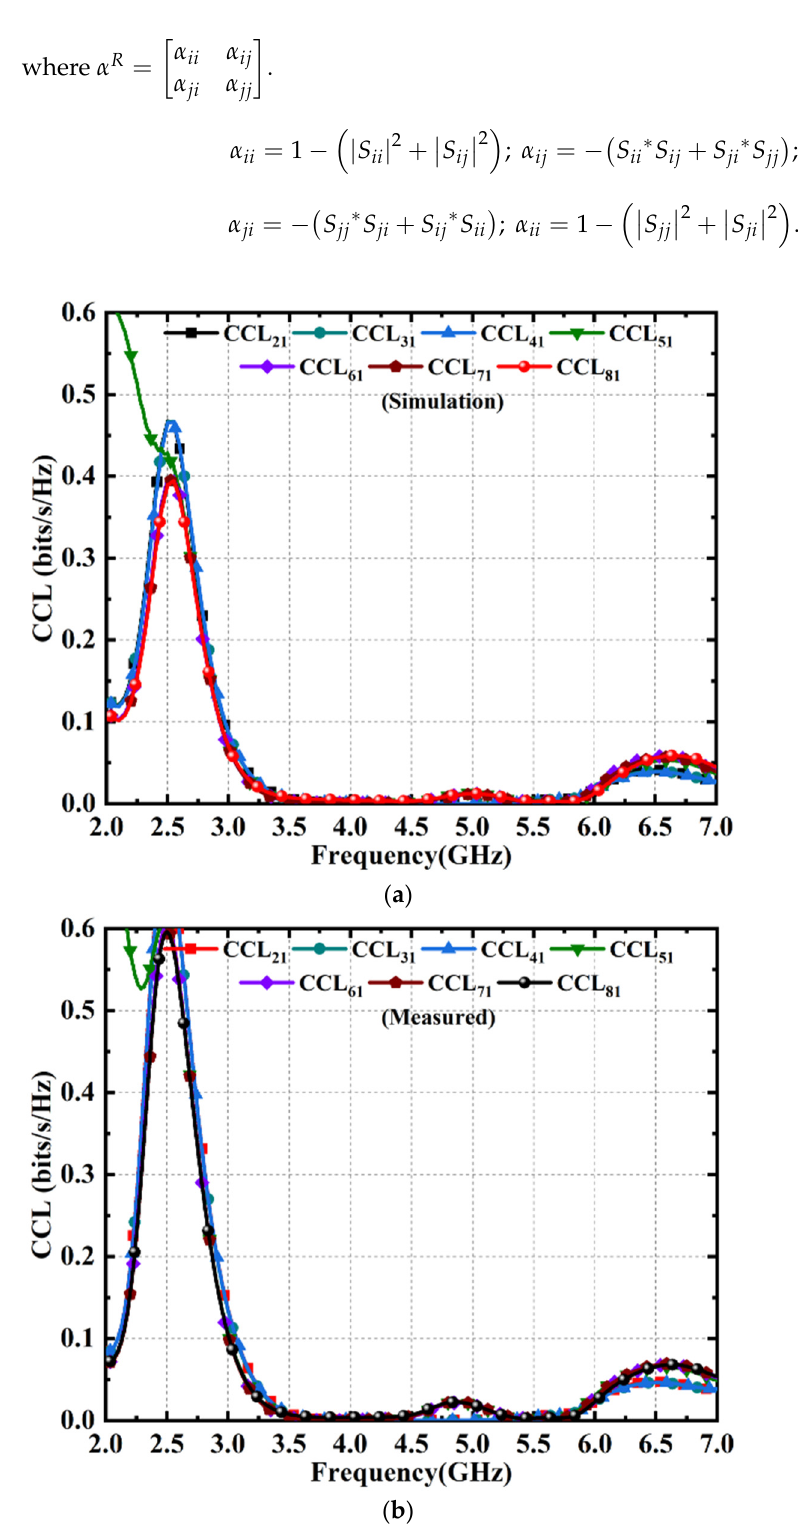
Figure 18. CCL response: ( a ) simulated and ( b ) measured. The mean effective gain (MEG) is a diversity performance indicating parameter that describes an antenna’s ability to receive electromagnetic signals in a multipath environ- ment [38]. Equation (11) is used to calculate the MEG of the proposed antenna. Figure 19a,b illustrates the simulate and measured MEG plots, respectively. It is seen that the MEG of − 3 dB is obtained in complete band from 3.3 to 6.0 GHz.